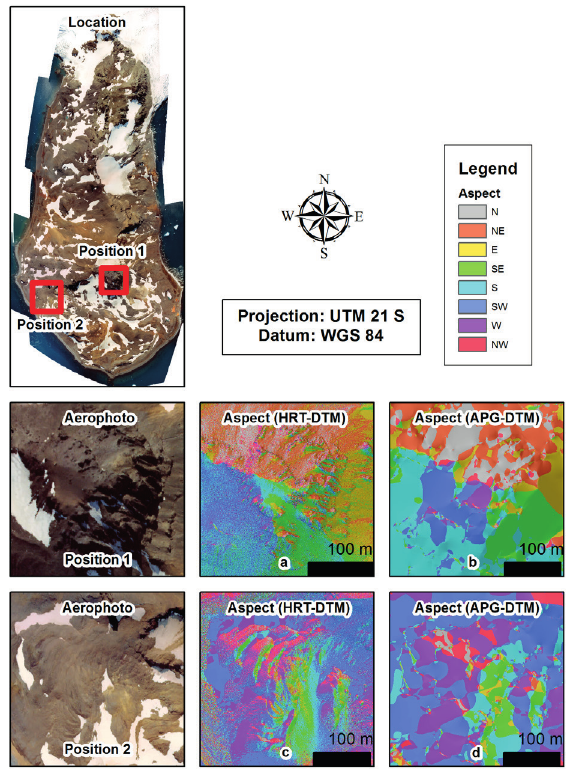
Figure 7 - Illustrative representation of the Slope for the HRT-DTM (a and c) and the APG-DTM (b and d) in two different positions (Aerophotos adapted from Francelino M.R., unpublished